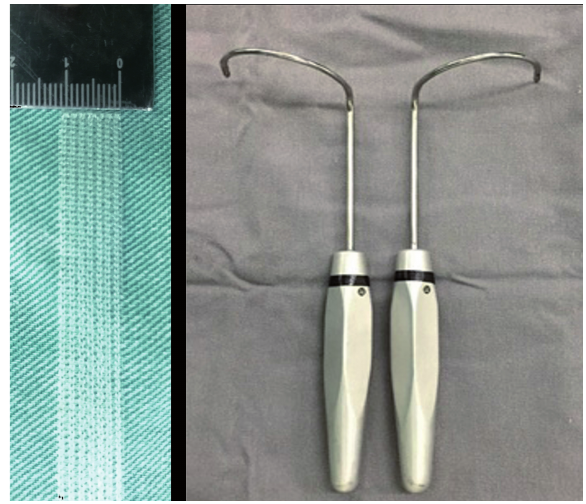
figure 1 - Hand-made polypropylene mesh /